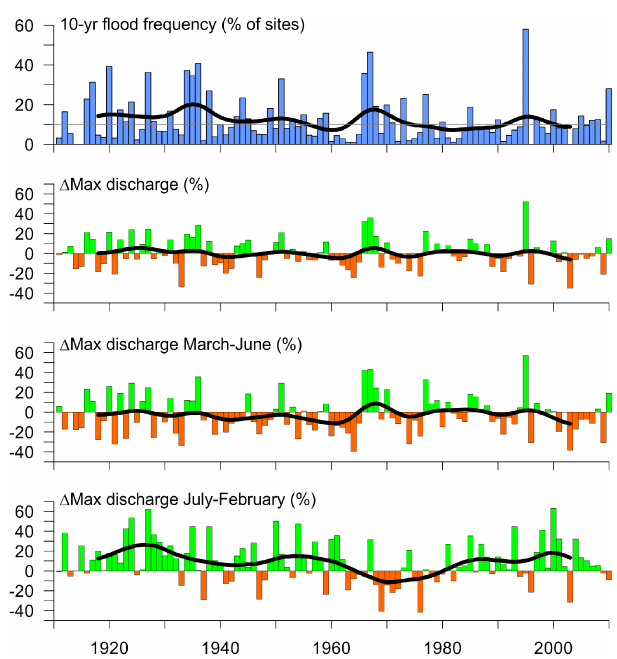
Figure 2. Observed annual high flow (1911–2010) versus the ref- erence period (1961–1990) for the 69 rivers, showing fractions of stations exceeding the 10-year flood each year, the mean devia- tion in the magnitude of annual maximum daily discharge, and the mean deviation in the magnitude of maximum daily discharge dur- ing March–June and July–February. The black line represents a 10- year Gauss filter.